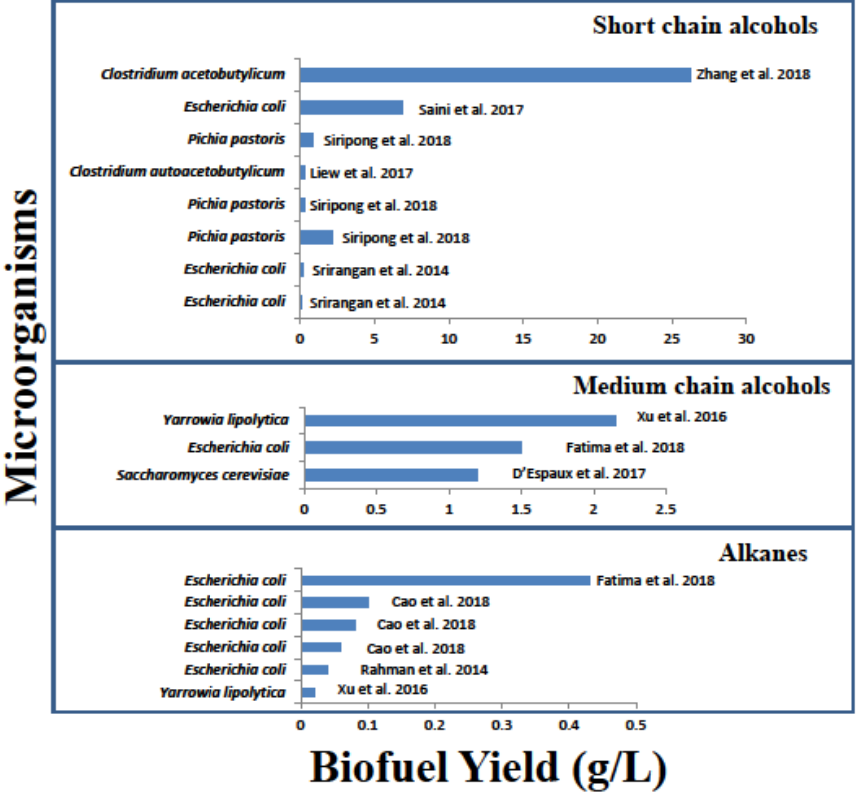
Figure 2. Recent studies on the production of short-chain alcohols, medium-chain alcohols and n -alkanes in microorganisms. The data represent batch fermentation experiments. For more detail, see Table